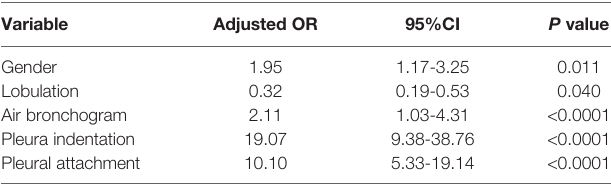
TABLE 2 | Variables and coef fi cients of clinical